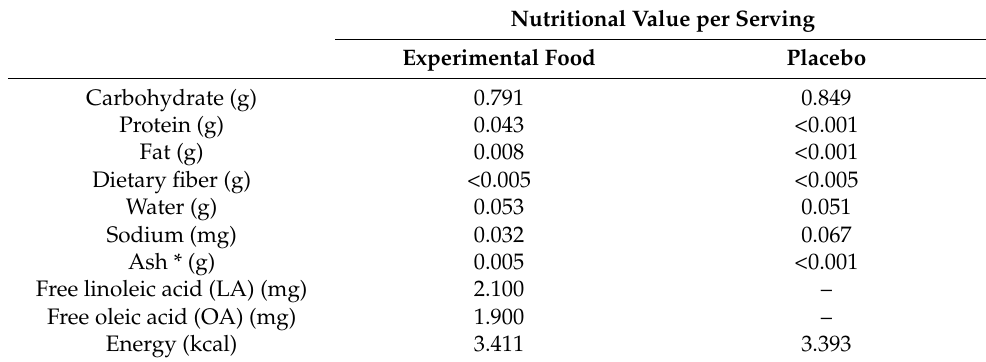
Table 1. Nutritional composition of the experimental food and the placebo.